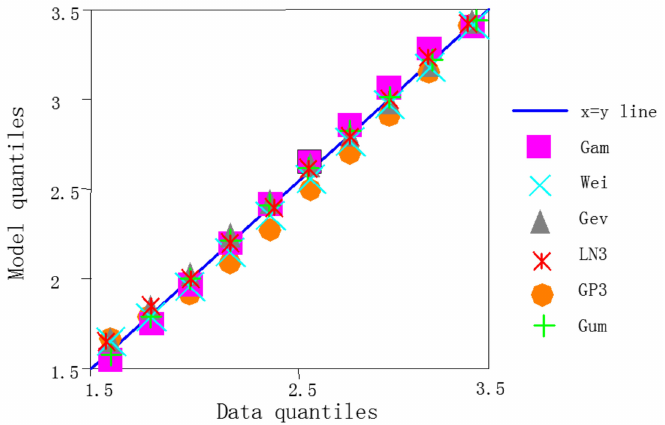
Figure 4. Q-Q plot in the range 1.5–3.5 for data and model quantiles.